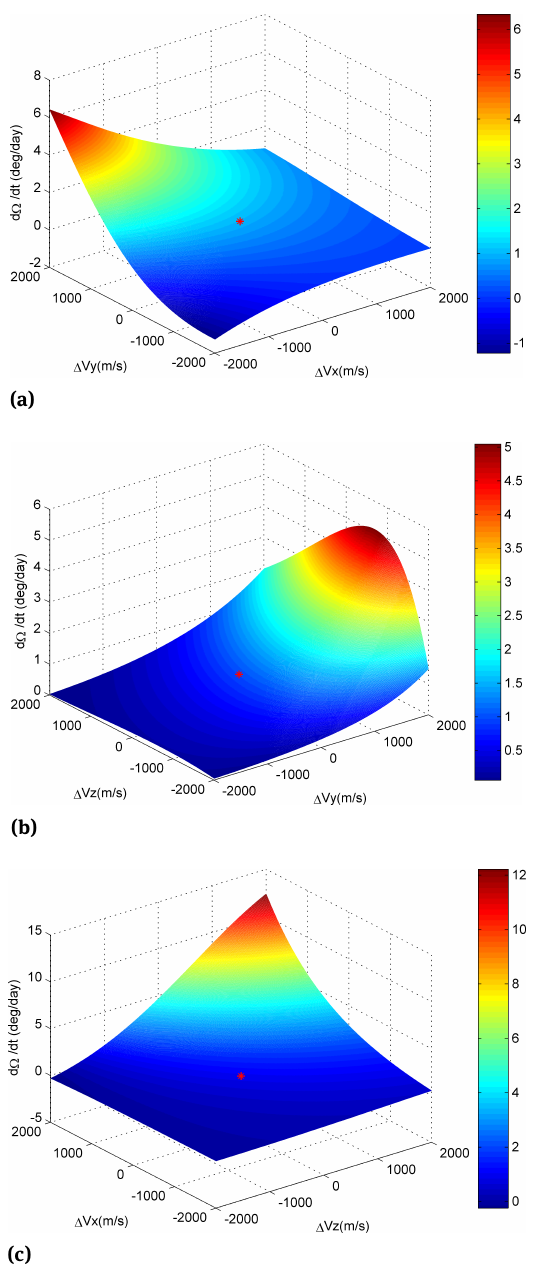
Figure 8. 2D plot of the relative relationship of the velocity error and the rate of change of the right ascension of the ascending node. (a) the velocity error is in the coordinate axes x and y; (b) the velocity error is in the coordinate axes y and z; (c) the velocity error is in the coordinate axes z and